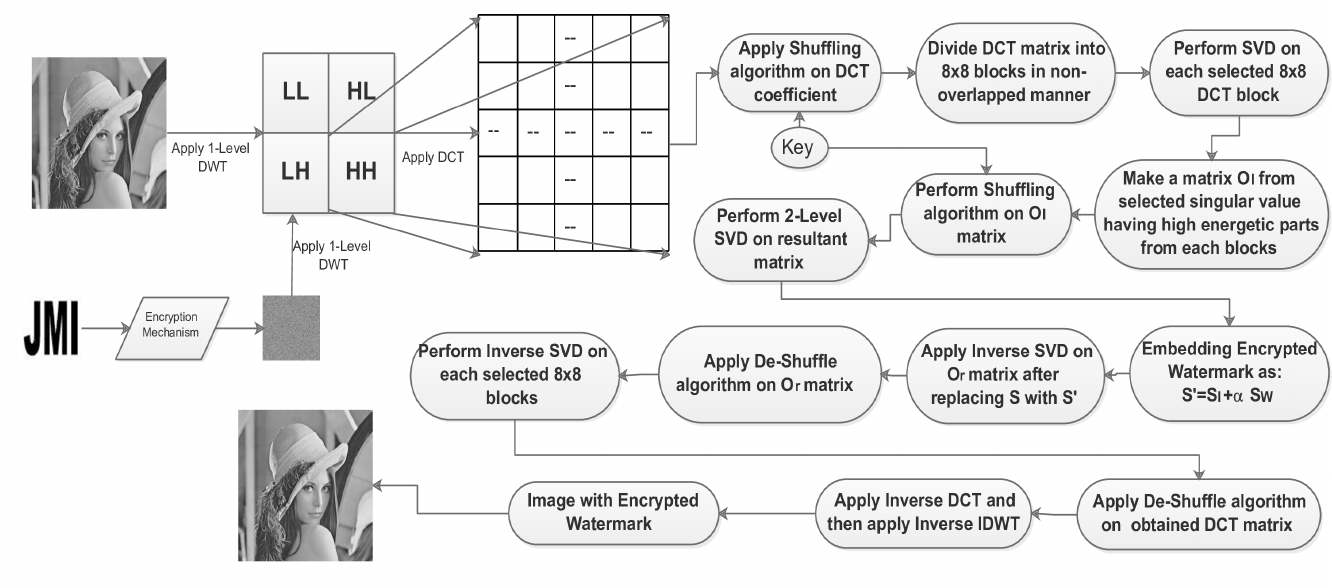
Fig 4. The block diagram of embedding